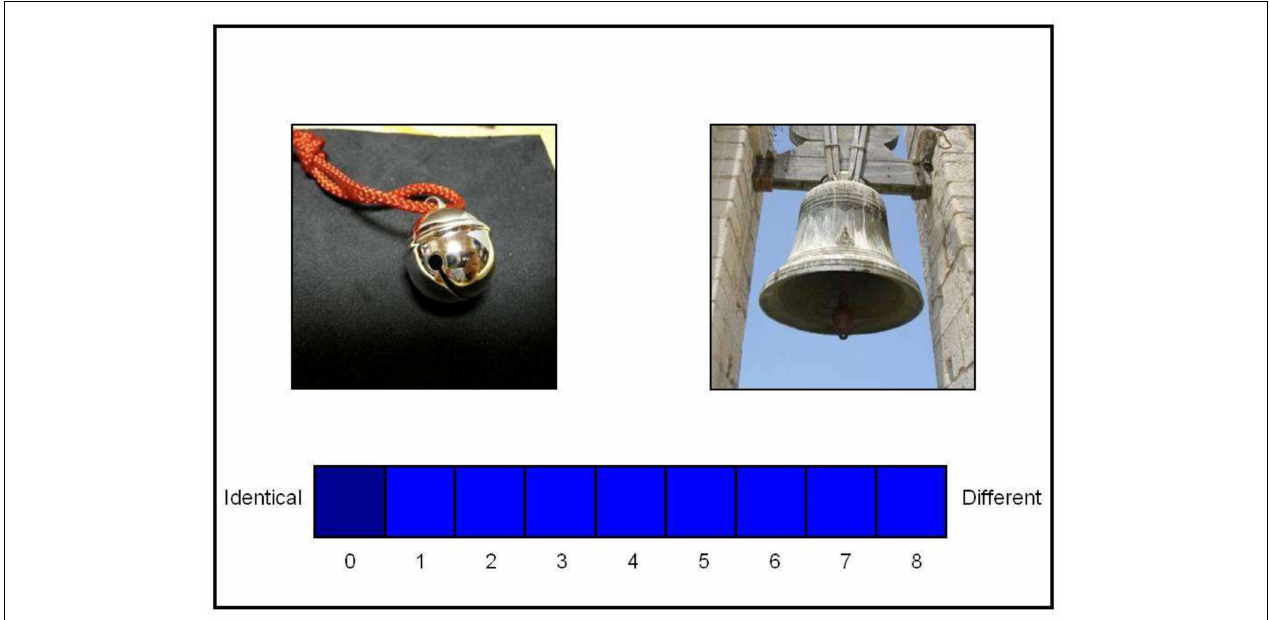
FIGURE 1 | An example of pairs of images, and a